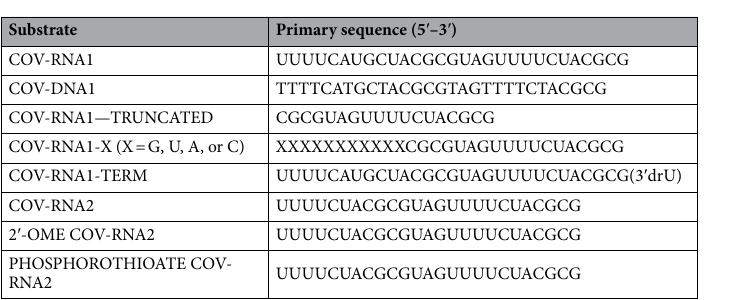
Table 1. RNA and DNA substrates used in binding and elongation assays.